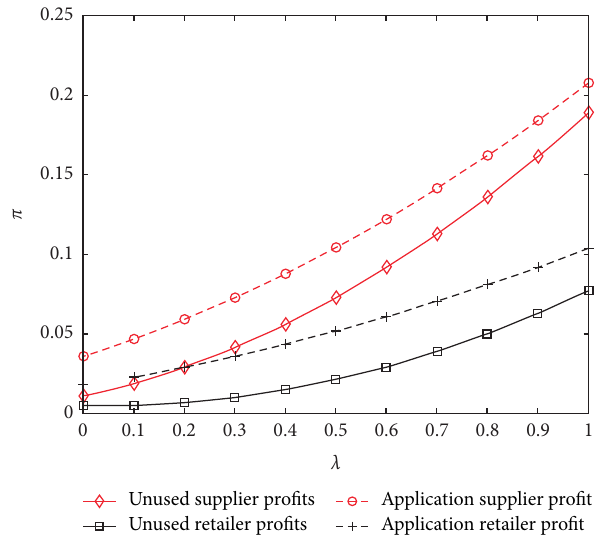
Figure 6: Relationship between supplier and retailer profit and reliability.